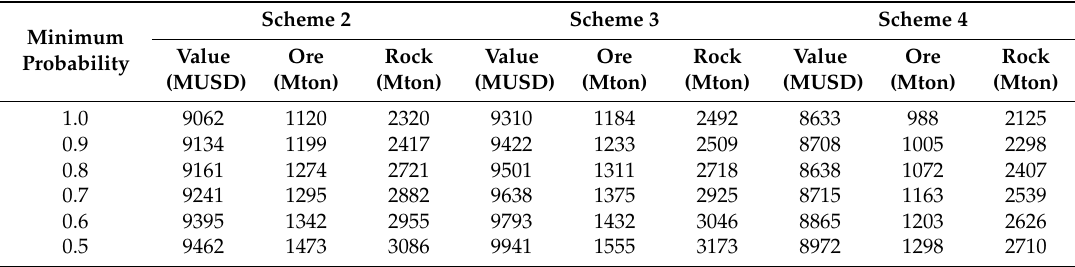
Figure 11. S-N sections, E views for probability models (FP prob) and a specific probabilistic ultimate pit limit for 90% reliability (FP 90%). ( a ) Scheme 2—probability final pit; ( b ) Scheme 2—90% probability final pit; ( c ) Scheme 3—probability final pit; ( d ) Scheme 3—90% probability final pit; ( e ) Scheme 4—probability final pit; ( f ) Scheme 4—90% probability final pit. Table 6. Summary of ultimate pit limits by using hybrid pits methodology [50]. Values were re-evaluated by using the economic model of Scheme 3 for comparison.